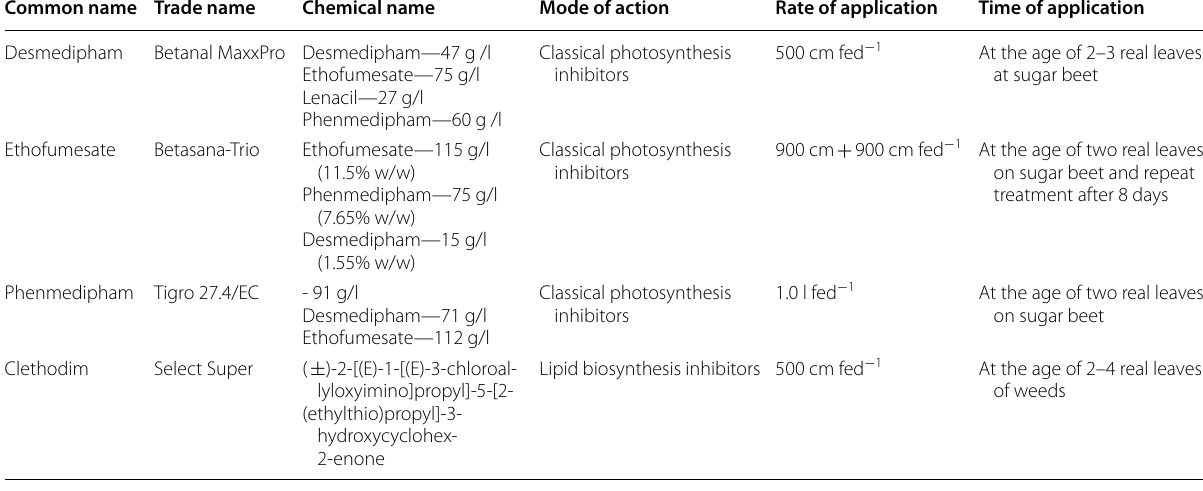
Table 2 Common, trade and chemical names of the herbicides used as well as mode of action, rate and time of